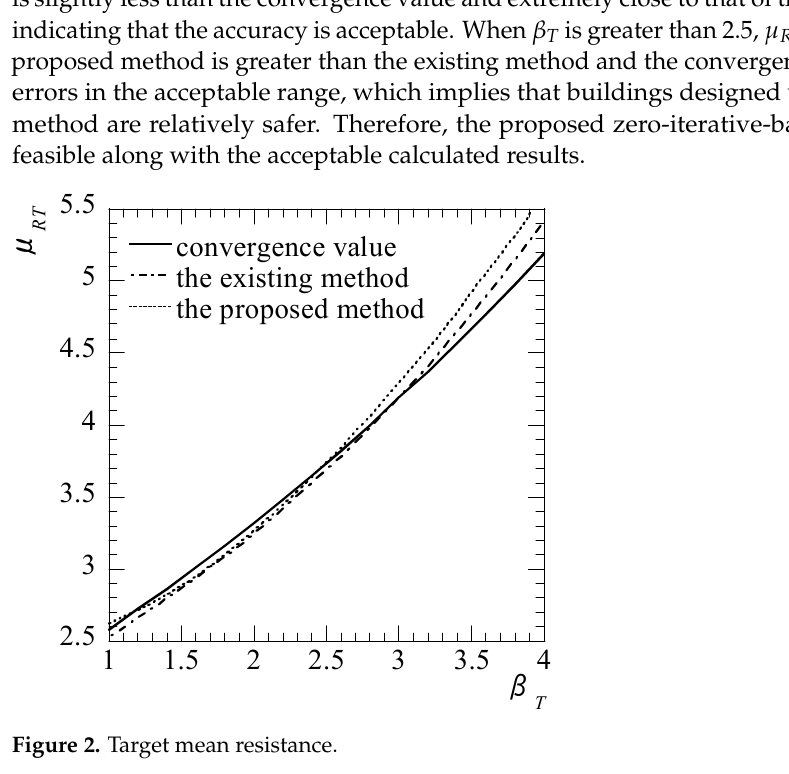
Table 3. Basic random variables for Equation (44). RVs